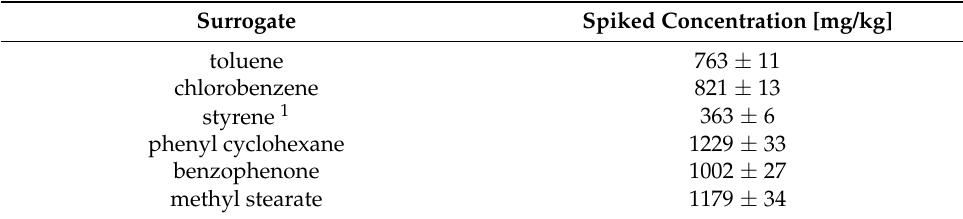
Table 5. Experimentally determined concentrations of model compounds in the spiked HIPS sheet. Surrogate Spiked Concentration